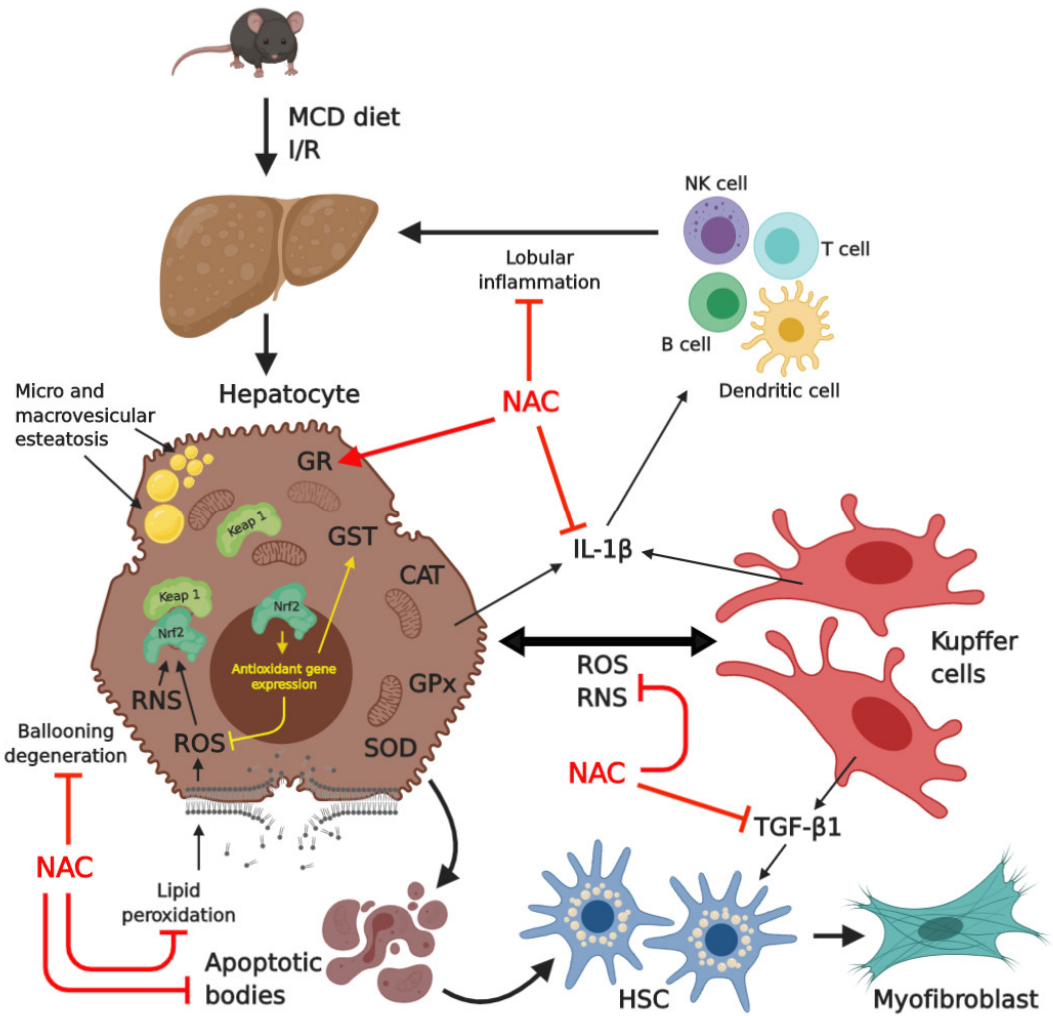
Figure 7. This is a schematic representation of all of the effects of N -acetylcysteine (NAC) in mice livers with MCD diet-induced steatohepatitis submitted to I/R injury. NAC reduced lipid peroxidation, RSN, IL-1β, TGF-β1, inflammatory foci, and apoptosis and increased glutathione reductase.